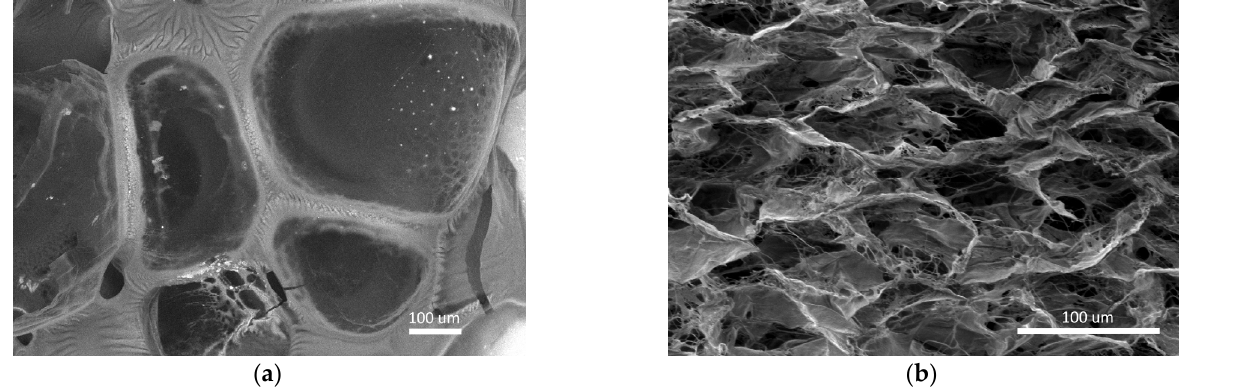
Figure 17. The porous structure of the studied materials (scanning electron microscopy): ( a )—biopolymer scaffold, ( b )—collagen matrices.